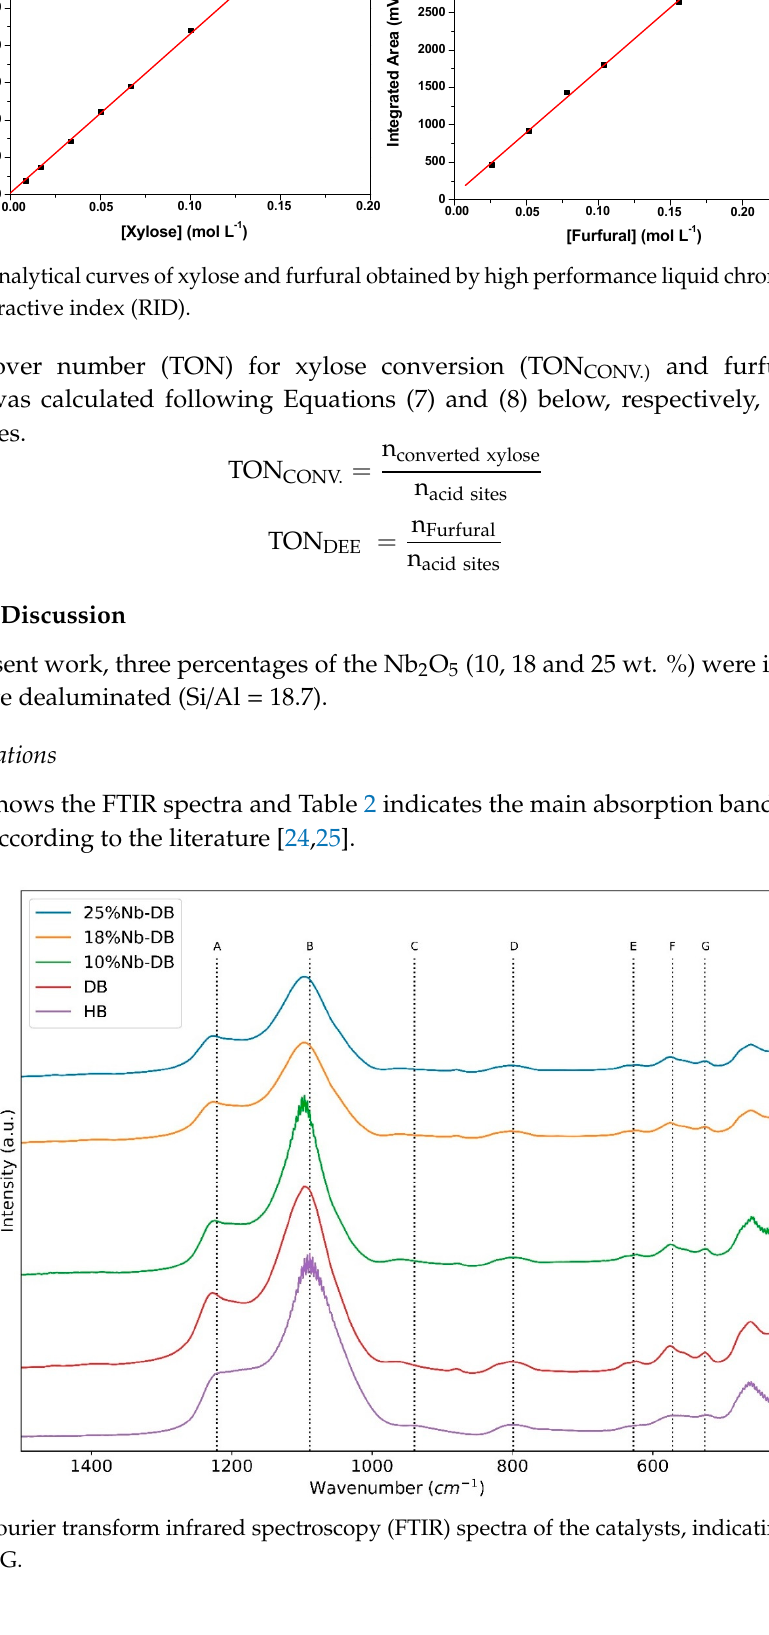
Figure 1. Analytical curves of xylose and furfural obtained by high performance liquid chromatography (HPLC)-refractive index (RID).